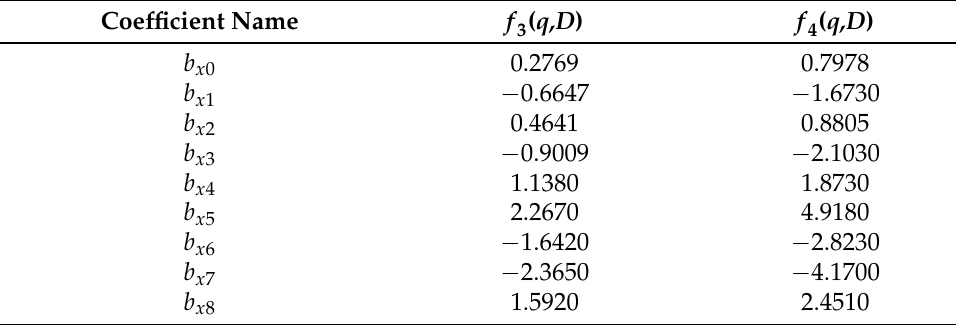
Figure 7. h m graphs. ( a ) 3D plot. ( b ) Fitting residuals. Table 2. Coefficients of h m